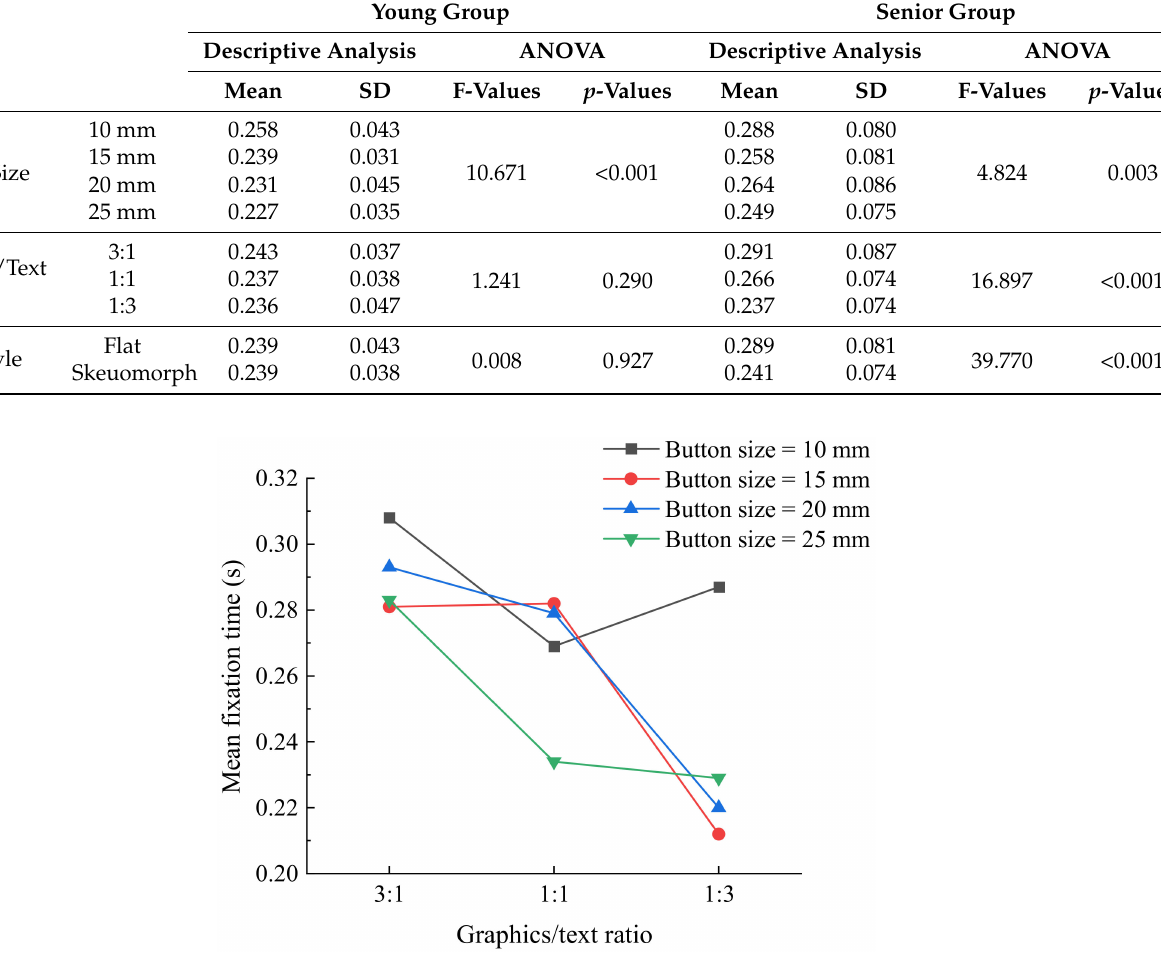
Figure 4. Mean fixation time (s) by graphics/text ratio and button size for senior group.